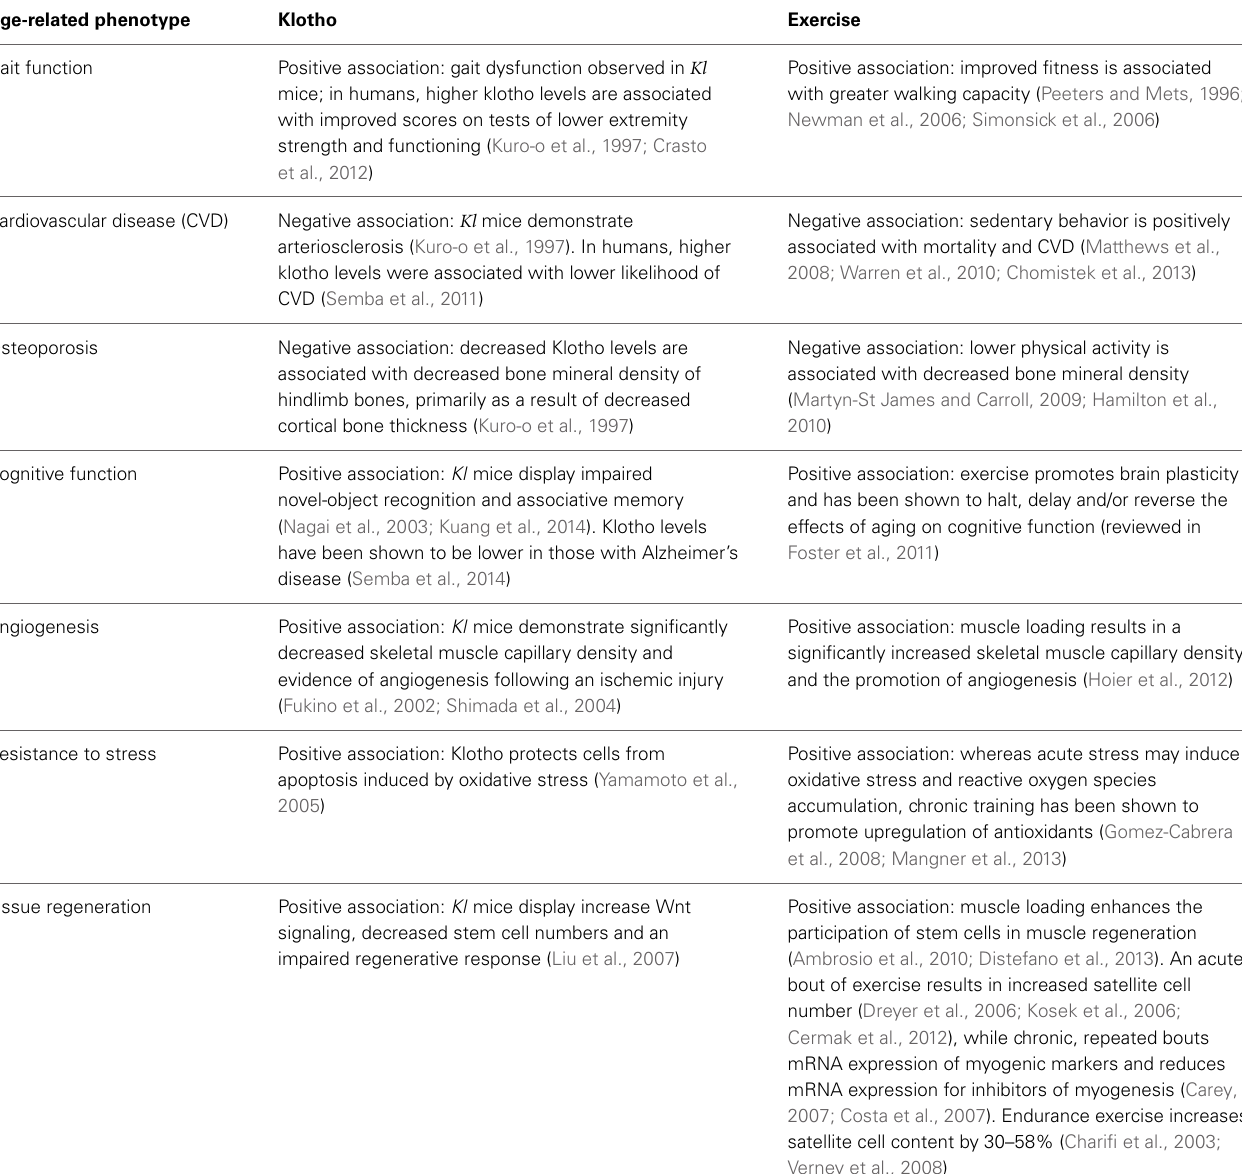
Table 1 | Summary depicting overlapping physiological and functional responses to Klotho expression and exercise/physical activity. Age-related